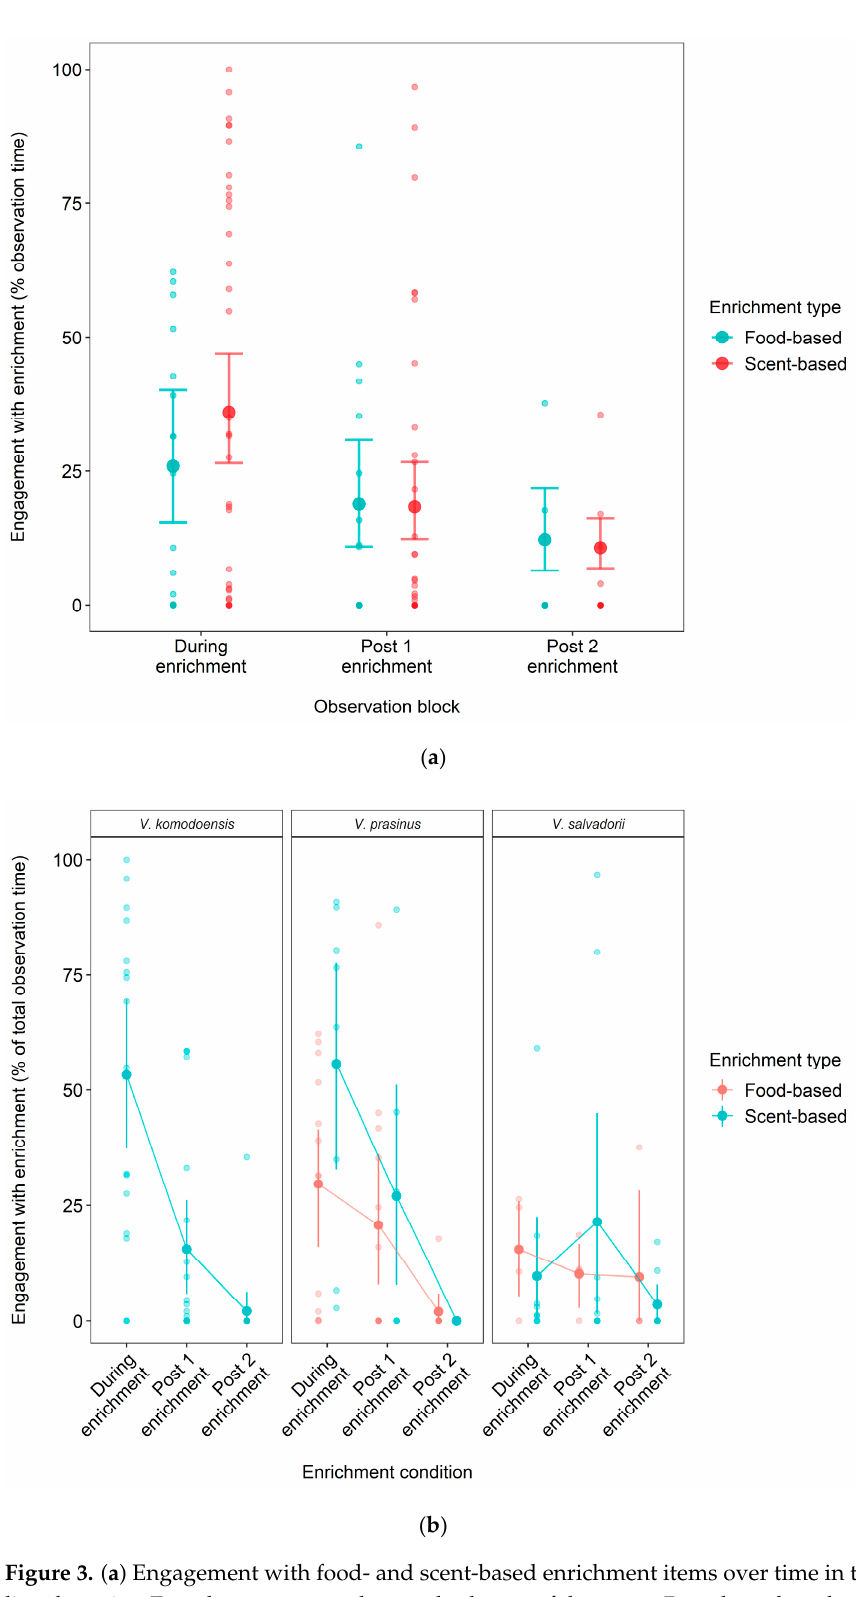
Figure 3. ( a ) Engagement with food- and scent-based enrichment items over time in three varanid lizard species. Error bars represent the standard error of the mean. Raw data plotted as small circles behind the main plot. ( b ) Species-specific engagement with food- and scent-based enrichment items in three varanid lizard species. Large points and error bars represent raw data means and 95% non-parametric bootstrap (10,000 samples) confidence intervals. Small points represent individual trials (raw data).